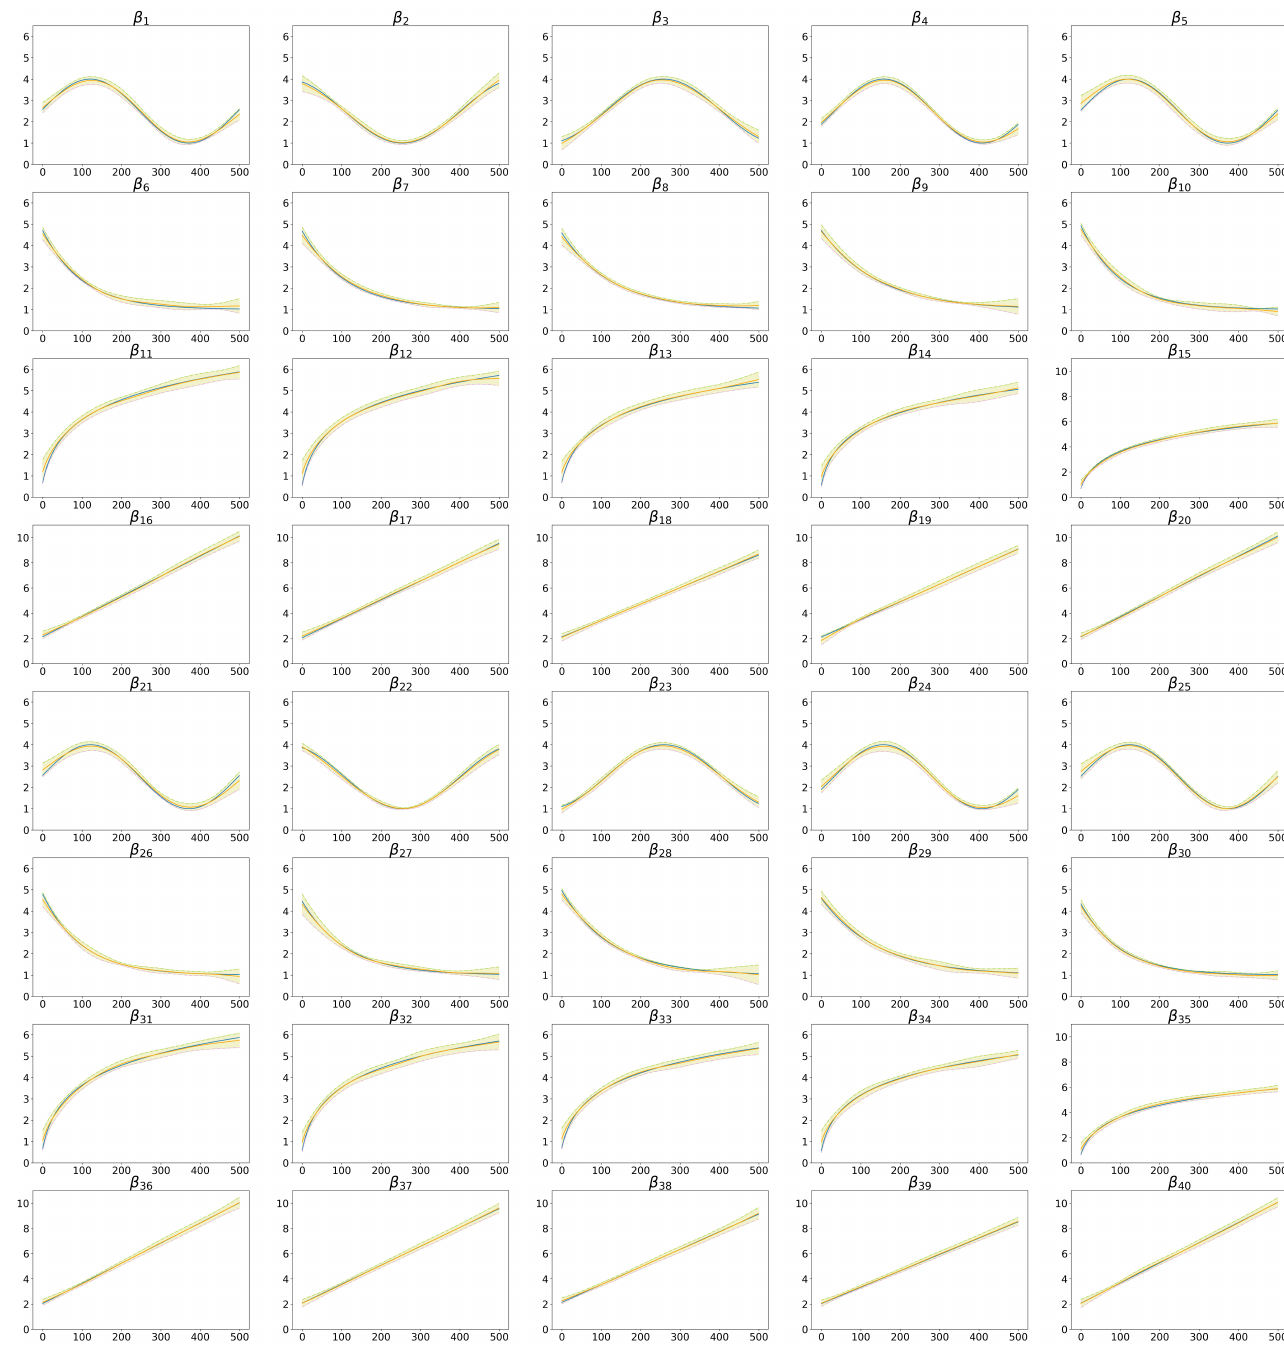
Figure A4. Estimated coefficients under Scenario 5 with N = 500, q = 40, and ρ = 0.8. The blue lines represent the true coefficients, the orange ones the coefficients estimated by New-Mar, and the shadowed areas the 95% confidence intervals. The x -axis represents the subjects, and the y -axis represents the coefficient